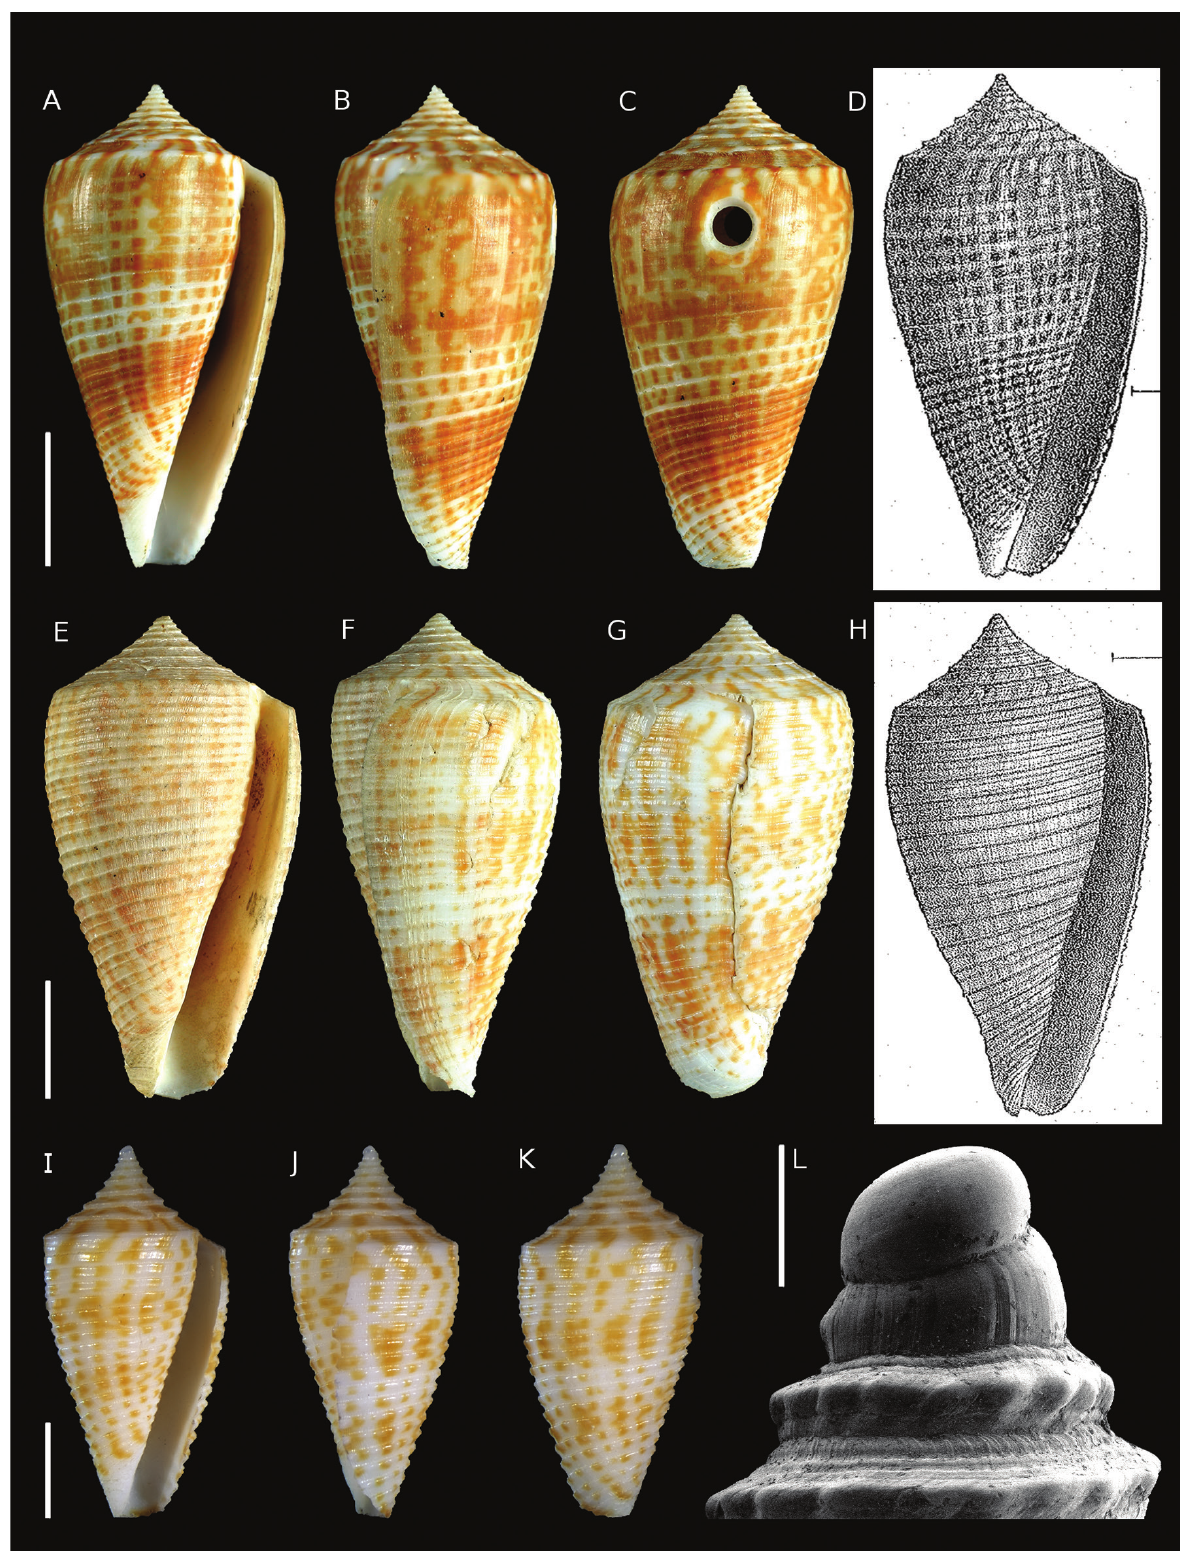
Figure 27. Conus planiliratus var. batheon Sturany, 1903. A–C . Figured syntype, NHMW 84227, Station 143 (Harmil Island, Dahlak Archipelago, Eritrea, Red Sea): front ( A ), right side ( B ), back ( C ). E–G . Figured syntype, NHMW 84225, Station 127 (Akik Seghir, Eritrea, Red Sea): front ( E ), right side ( F ), back ( G ). I–L . Syntype, juvenile specimen, NHMW 84228, Station 143 (Harmil Island, Dahlak Archipelago, Eritrea, Red Sea): front ( I ), right side ( J ), back ( K ), protoconch ( L ). D , H . Original figures by Sturany (1903). Scale bars: A–C , E–G : 10 mm, I–K : 5 mm, L : 0.5